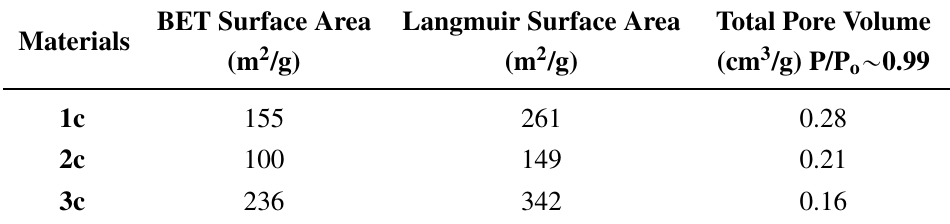
Table 1. Pore characteristics of the synthesized nanoporous carbon materials.